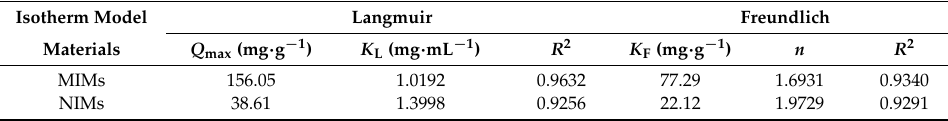
Table 2. Isotherm model and constants of MIMs, NIMs for Cyt c.